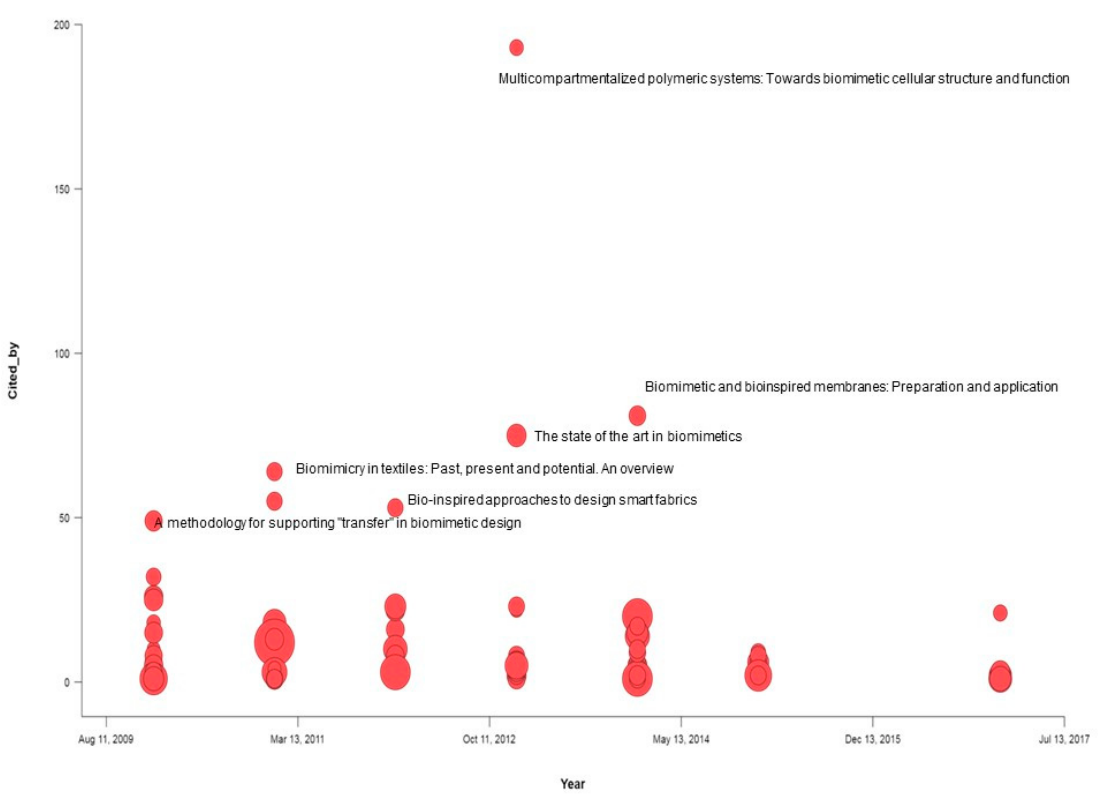
Figure 7. Papers on biomimetic approaches published between 2009 and 2017.